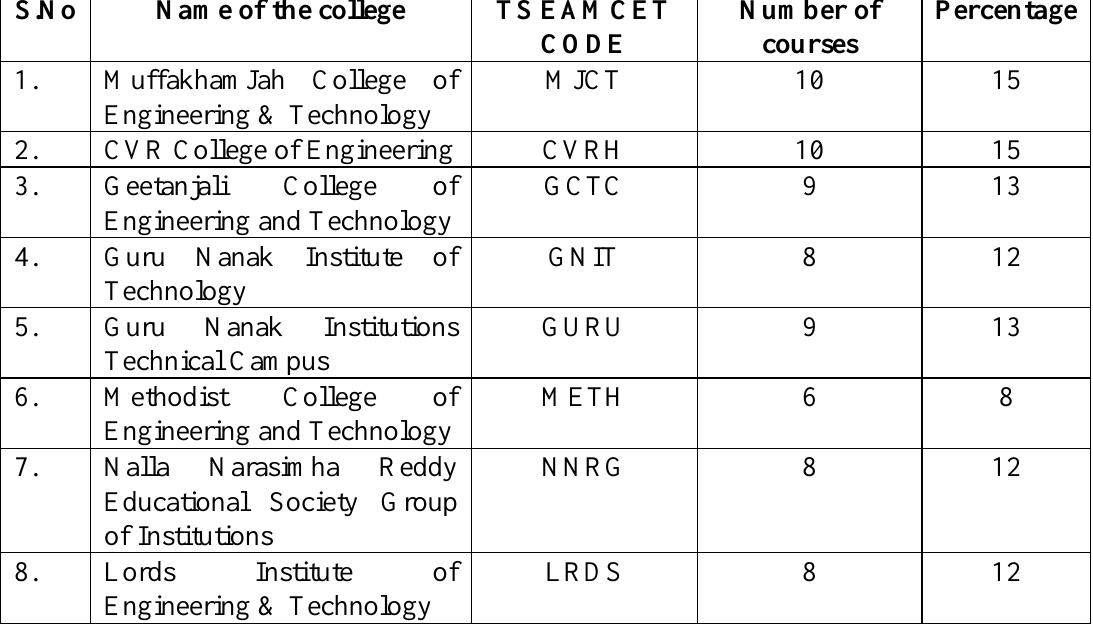
Table 3: Number of Courses from selected Engineering